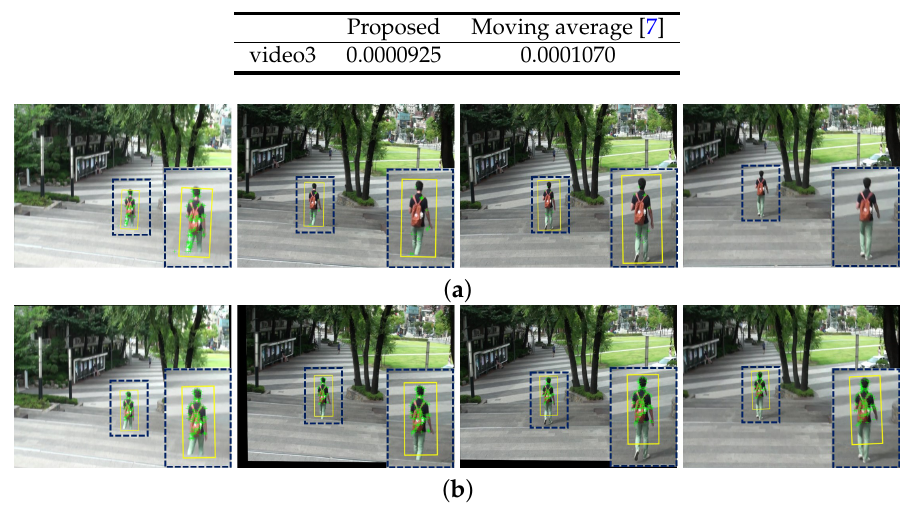
Figure 16. Experimental results of the object tracking: ( a ) shaky video and ( b ) stabilized